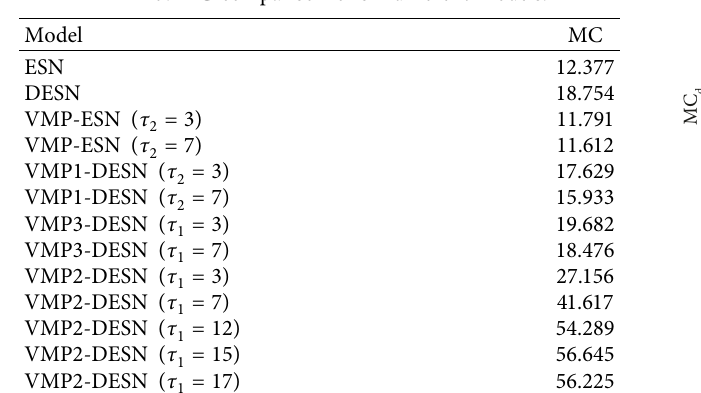
Table 5: MC comparison of six different models.